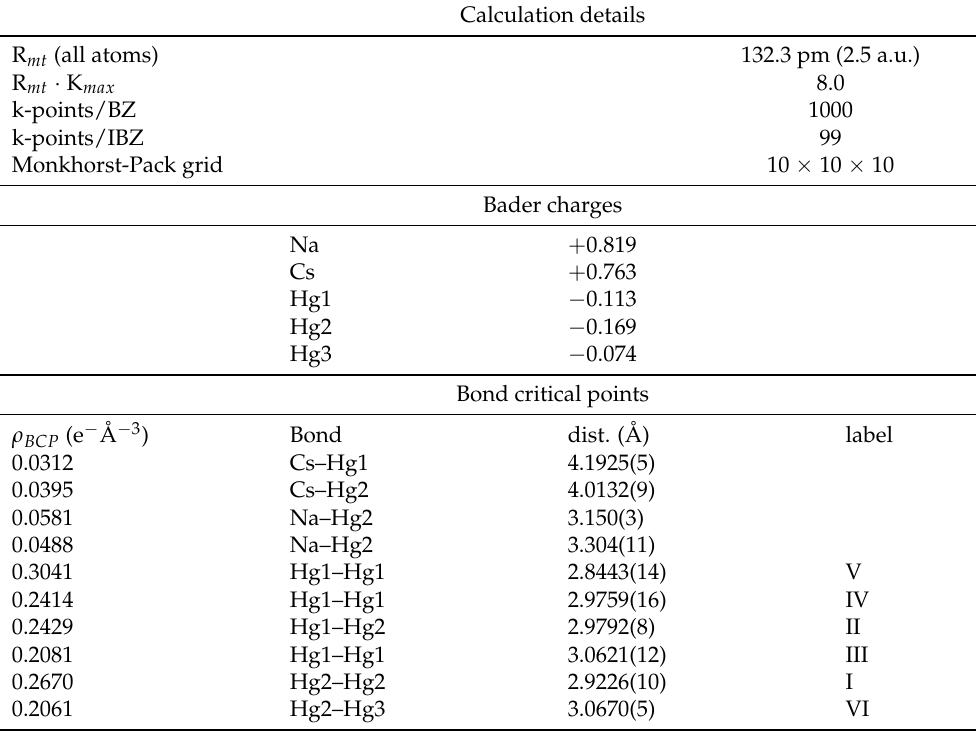
Table 6. Details of the calculation of the electronic structure of Cs 2 NaHg 18 together with Bader charges and bond critical points. The Hg–Hg bond labels are the same as in Figure